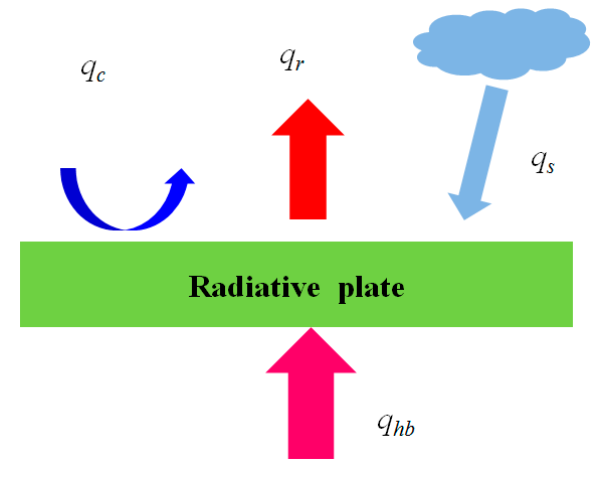
Figure 3. Radiative plate heat flux diagram [25].